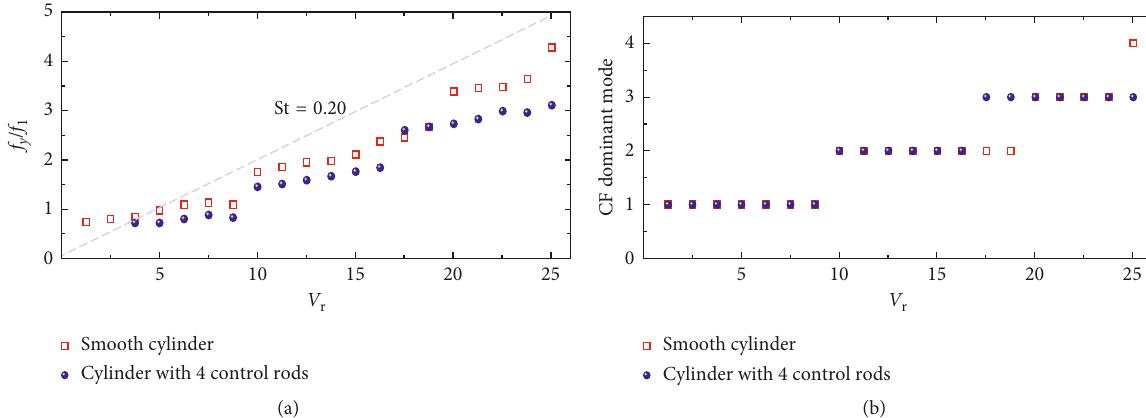
Figure 8: Dominant frequencies (a) and dominant modes (b) of the main vertical flexible cylinder with control rods versus the reduced